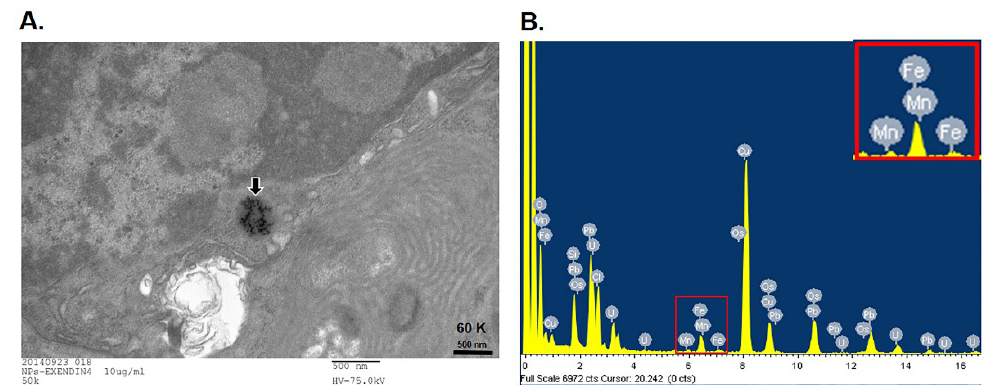
Figure 5. TEM micrographs of MIN6 cells incubated with 10 μ g/mL MnMEIO-Ex4 NPs. ( A ) Electron dense particles in an endocytotic vesicle was indicated by the arrow. ( B ) Elemental analysis by electron energy-loss spectroscopy in MIN6 cells labeled with 10 µ g/mL MnMEIO-Ex4 NPs. The peaks of manganese and iron were magnified in the inset box at top right corner.